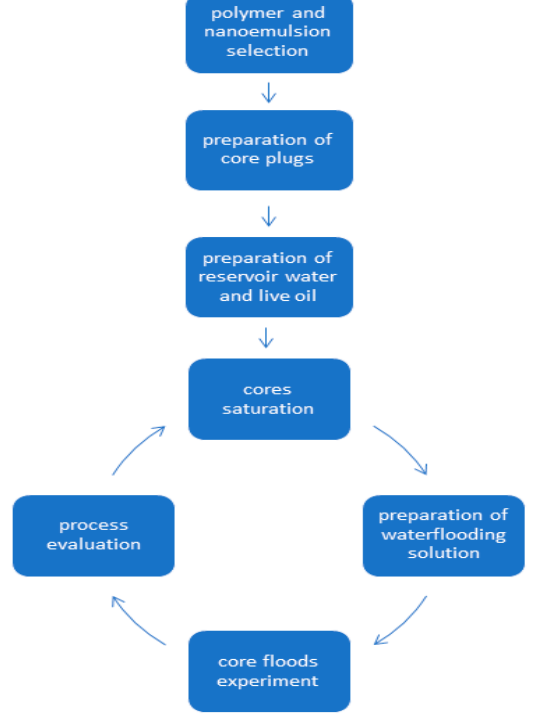
Figure 1. Flow chart diagram of the research.